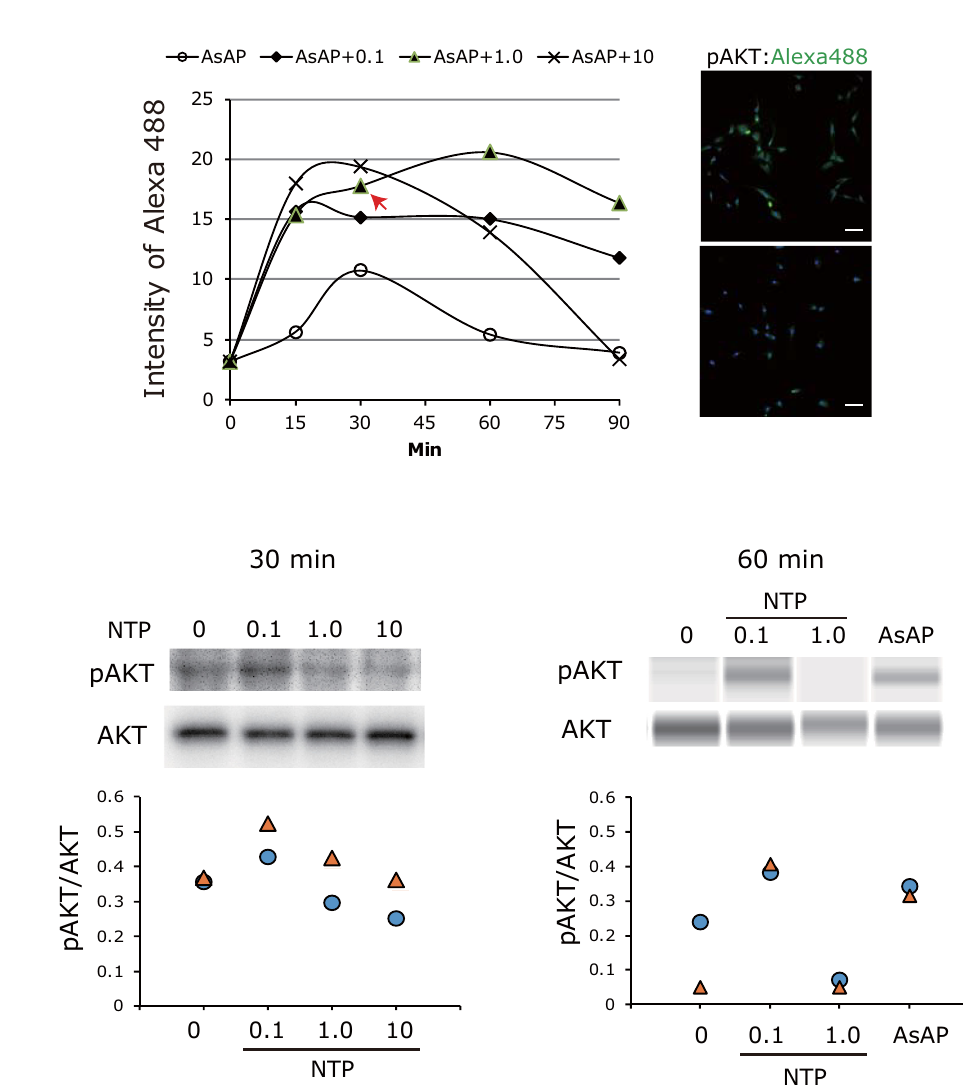
Fig 4. NTP activates AKT phosphorylation. Phosphorylation of AKT by NTP was examined in NP cells by staining with specific antibody against pAKT (Ser473). A) Time courses show the integrated signals of the Alexa Fluor 488-labeled pAKT (shown in green in the photograph) indicated peaks from 15 to 90 minutes after addition of NTP and AsAP. The peak levels of phosphorylation were much higher in the samples co-treated with 0.1, 1.0 and 10 mNU/ml NTP and AsAP than in those treated with AsAP only. Capture of immunofluorescence images and integration of the signal intensity in the cultured cells were performed using the ArrayScan system. Every serial sample was assayed in duplicated wells (Donor, N = 1). Red arrow shows the time point at which the representative photographs were taken. Nuclei are shown in blue by staining with DAPI. Bars are 100 μm. B) Western blot analysis of phosphorylation of AKT using the same antibody. Thirty minutes and 60 minutes after addition of NTP, cells were harvested and whole cell lysate was immunoblotted (N = 2). Addition of 0.1 mNU/ml NTP upregulated phosphorylation of AKT (Ser473) compared with control, but higher concentrations of NTP (1.0 and 10 mNU/ml) were not proportionally more effective (left and right). Addition of AsAP alone was also effective on AKT phosphorylation (right). AKT is constant under all culture